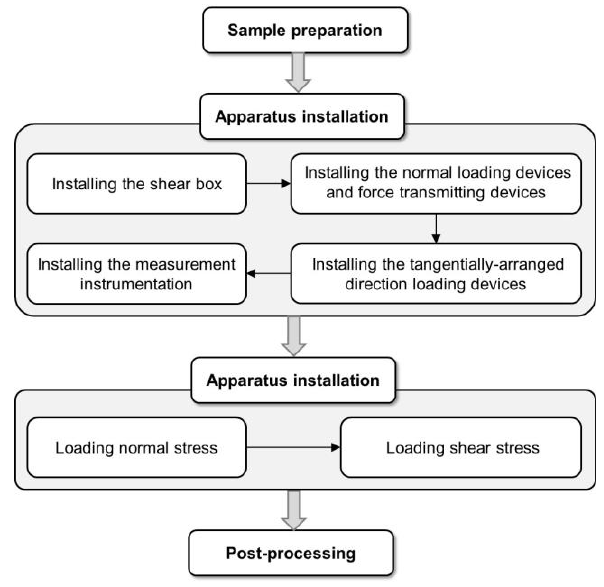
Figure 4. Flow chart for the in situ shear test of slip zone soil.